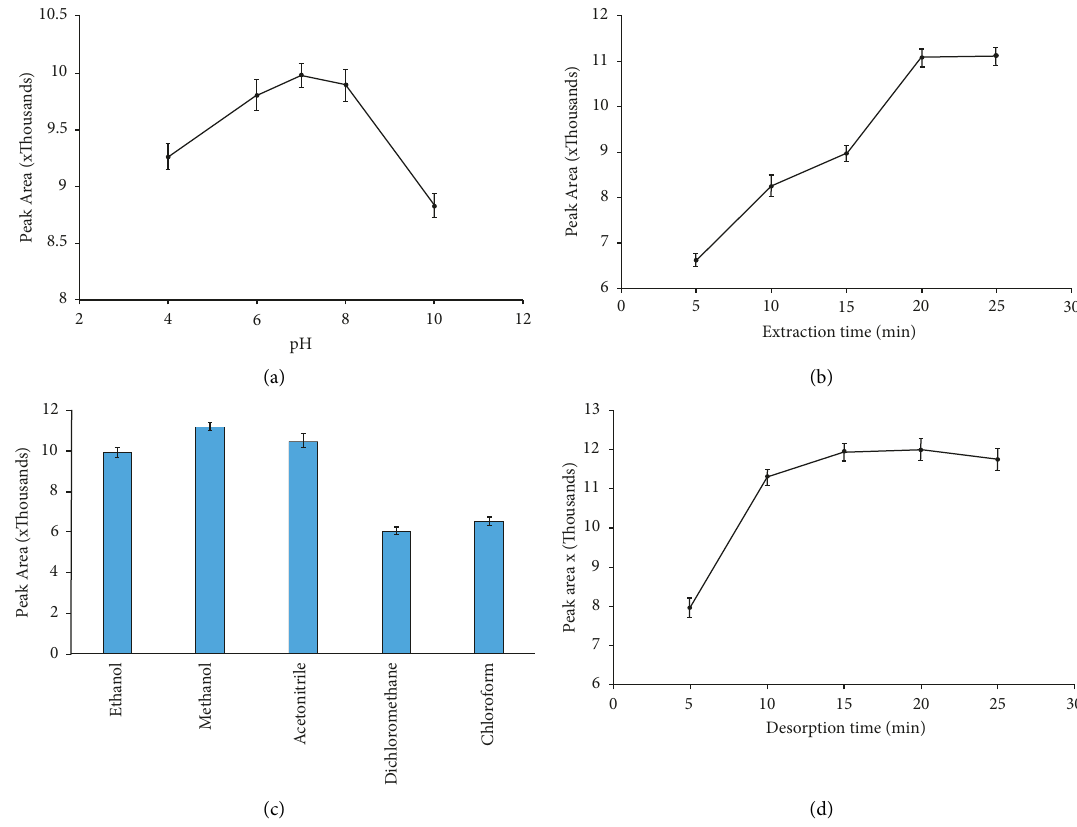
Figure 2: (a) Effect of pH on the extraction efficiency of SPME-MIP fiber for phenobarbital sample, extraction conditions: concentration of analytes; 0.1 μ g · mL − 1 , desorption solvent MeOH; extraction time: 20 minutes; desorption time: 15minutes; stirring rate: 600 rpm, (b) effect of extraction time, extraction conditions: pH 7 and others are the same as (a), (c) effect of desorption solvent, extraction conditions: extraction time 20 minutes and others the same as (b) and (d) effect of desorption time, extraction conditions: the same as (c) and extraction solvent: